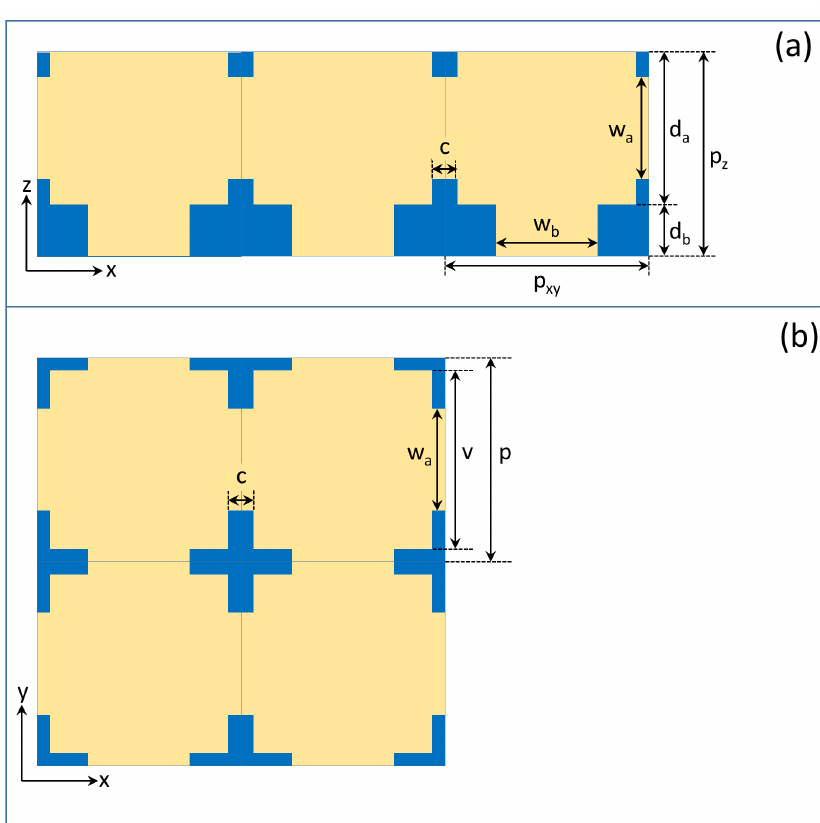
Figure 4. Vertical and horizontal cross-sections of the 3D model shown in Figure 3, with the characteristic sizes. Blue is chitin, and yellow is air. ( a ) The vertical cross-section of one-story, three-unit cells is shown. ( b ) The horizontal cross-section of a 2 × 2 unit cell section is